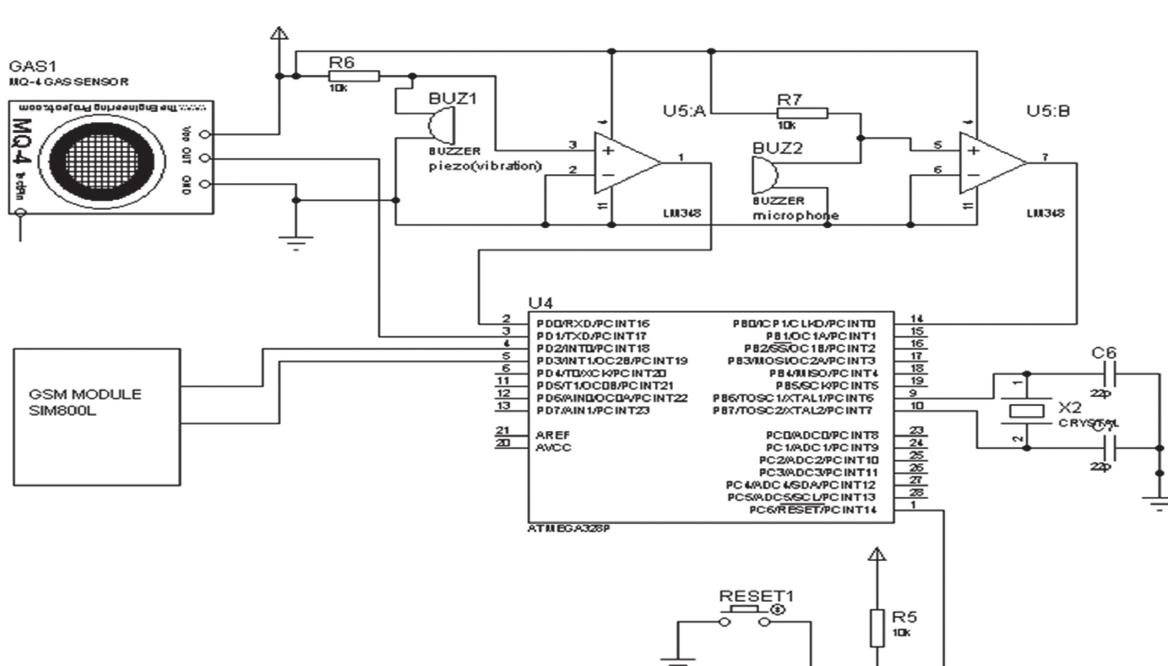
Figure 3: Field unit printed circuit